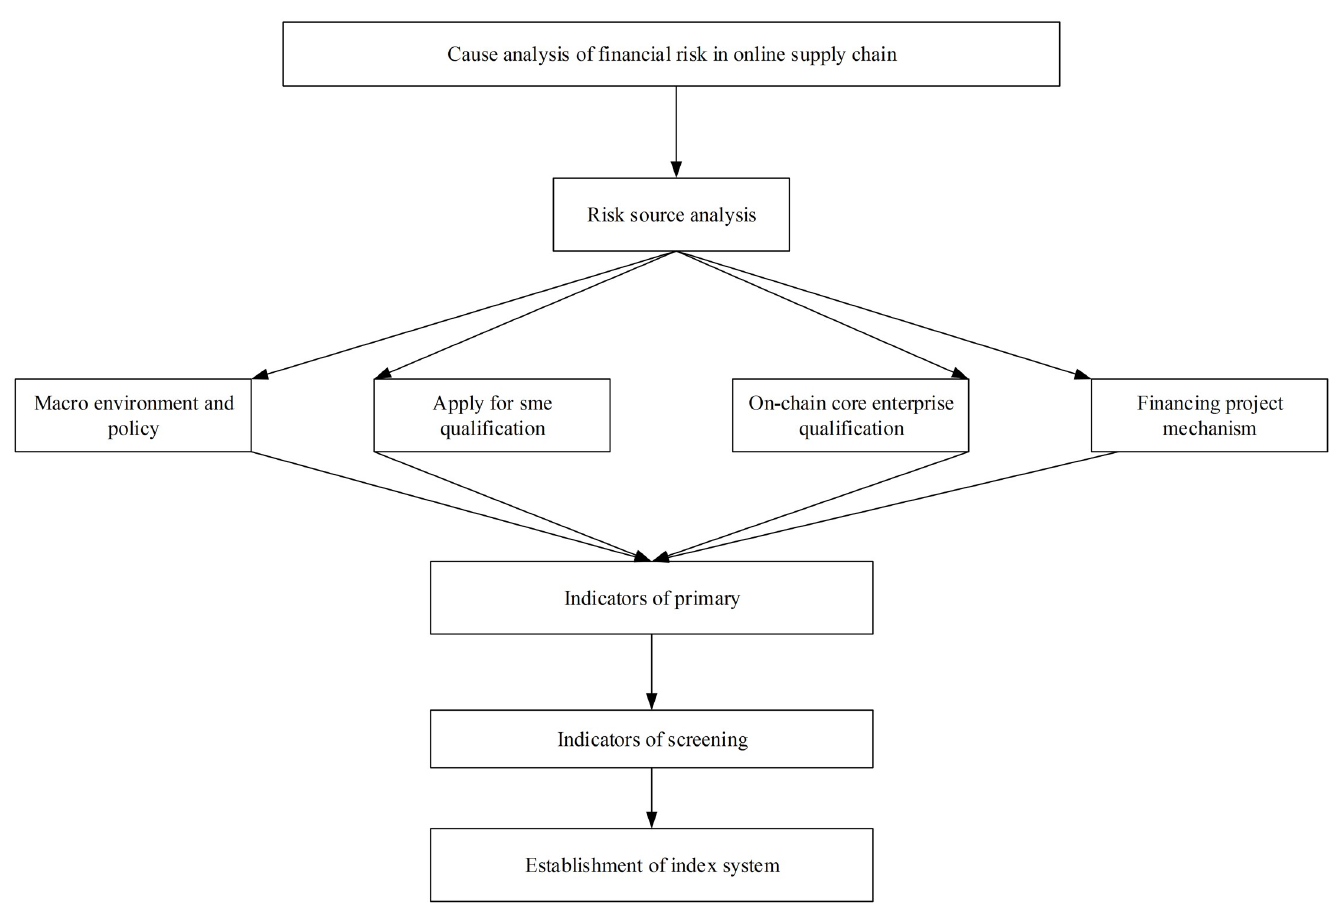
Fig 1. The research ideas of this